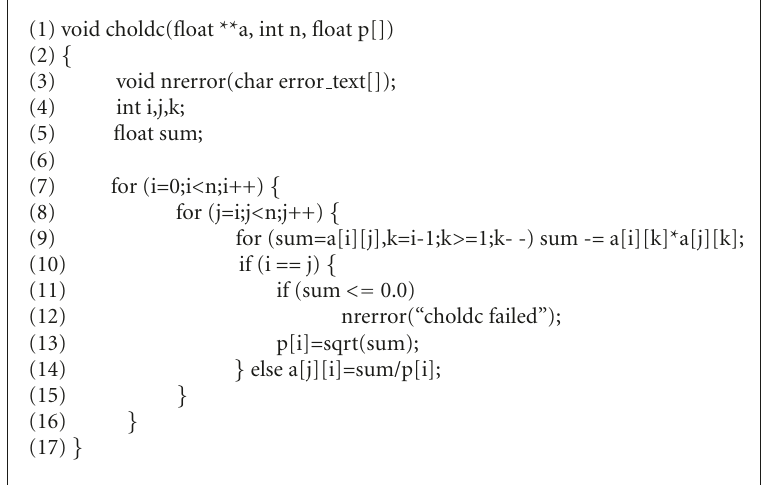
Figure 6: Floating point code for Cholesky